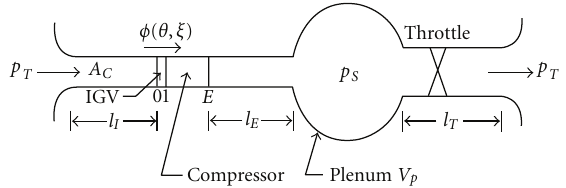
Figure 1: Schematic of the compressor showing nondimensional lengths (Erskine and Hensman